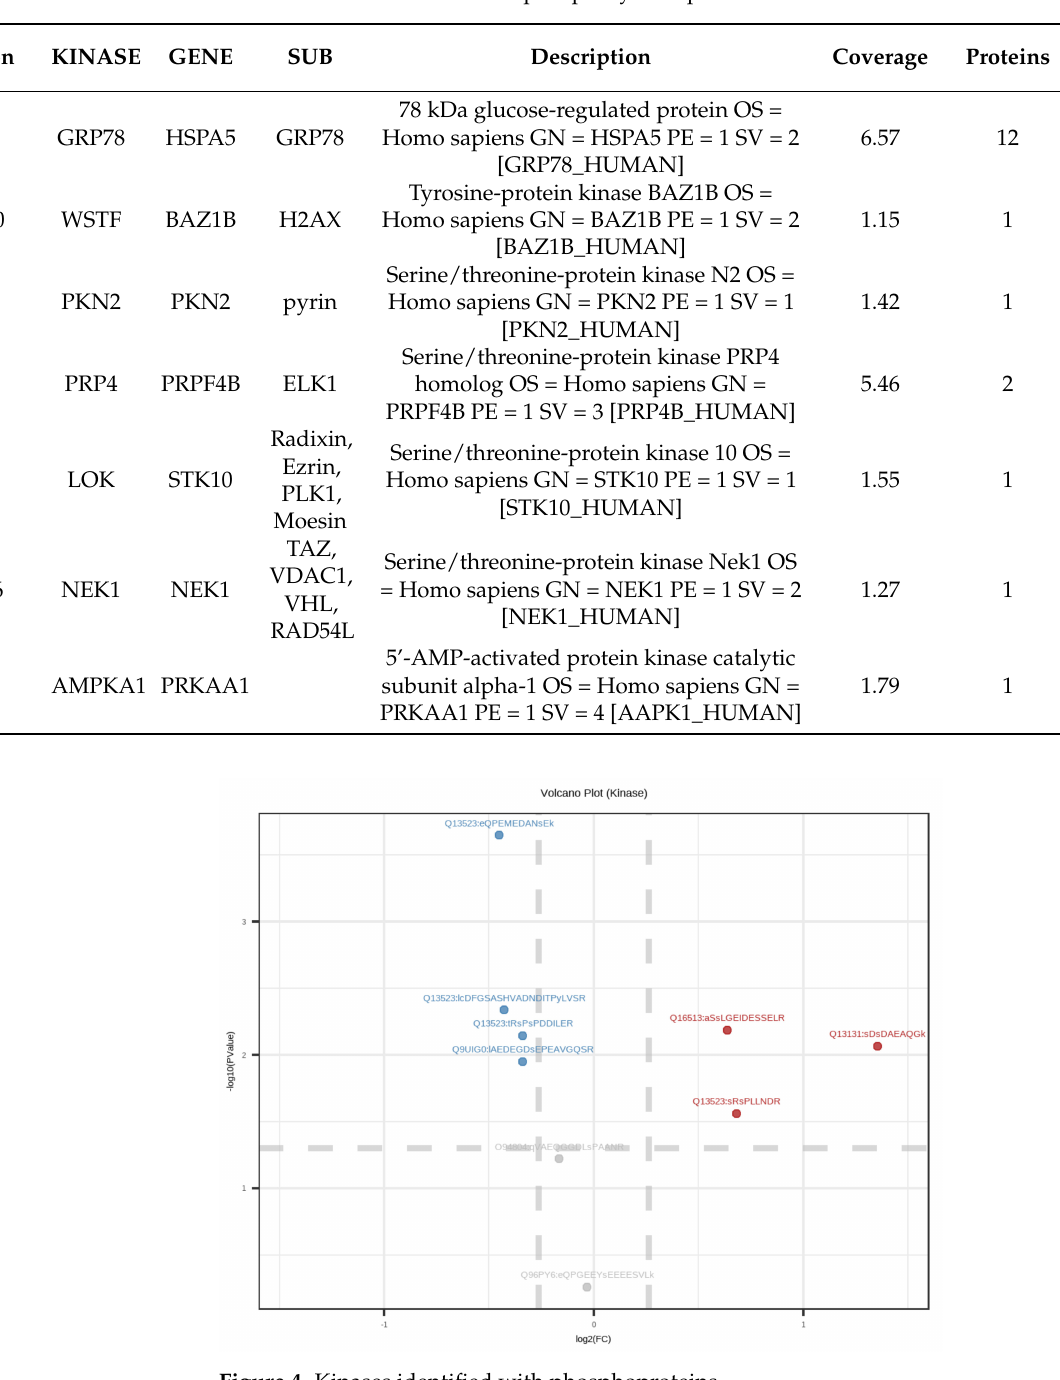
Table 2. The identified kinases based on the identified phosphorylated proteins in human nonfunctional PitNETs.